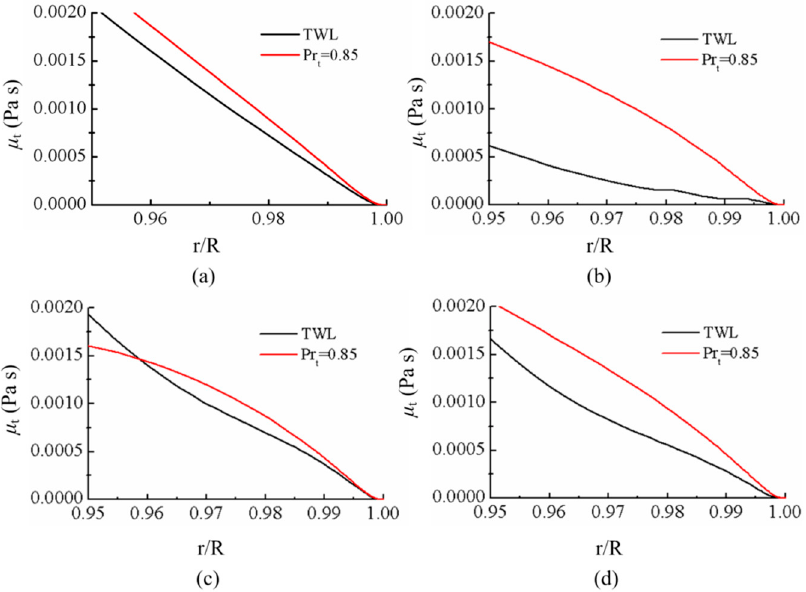
Figure 10. Distribution of turbulent viscosity in different sections: ( a ) x/D = 13; ( b ) x/D = 26; ( c ) x/D = 39; ( d ) x/D = 79.